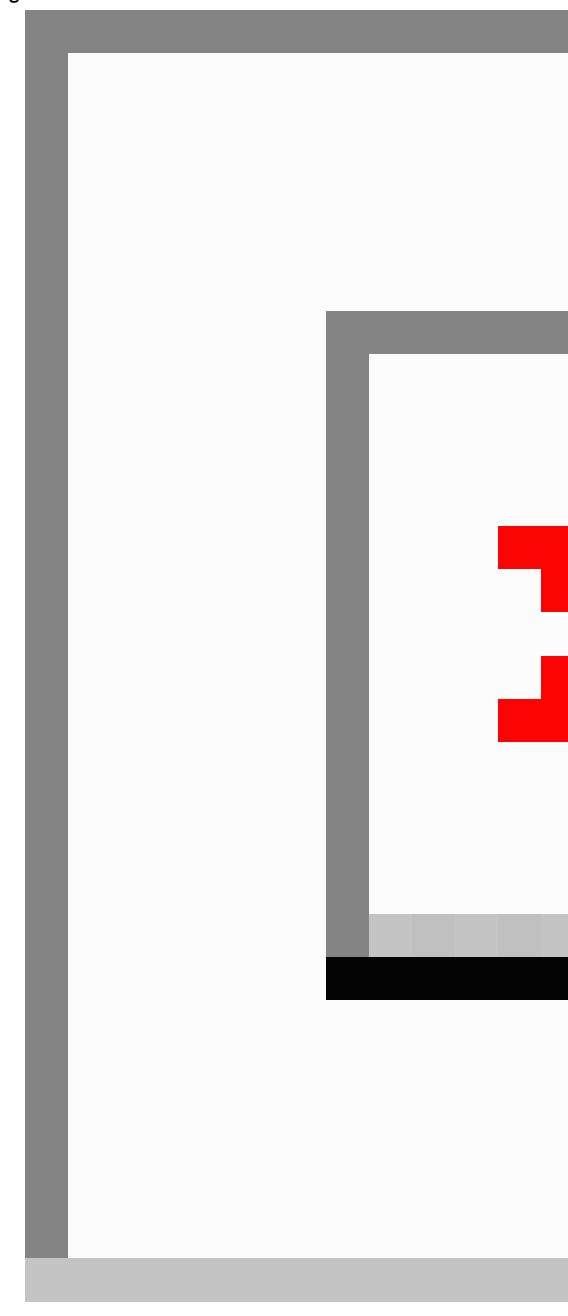
Figure 1. Patient recruitment.